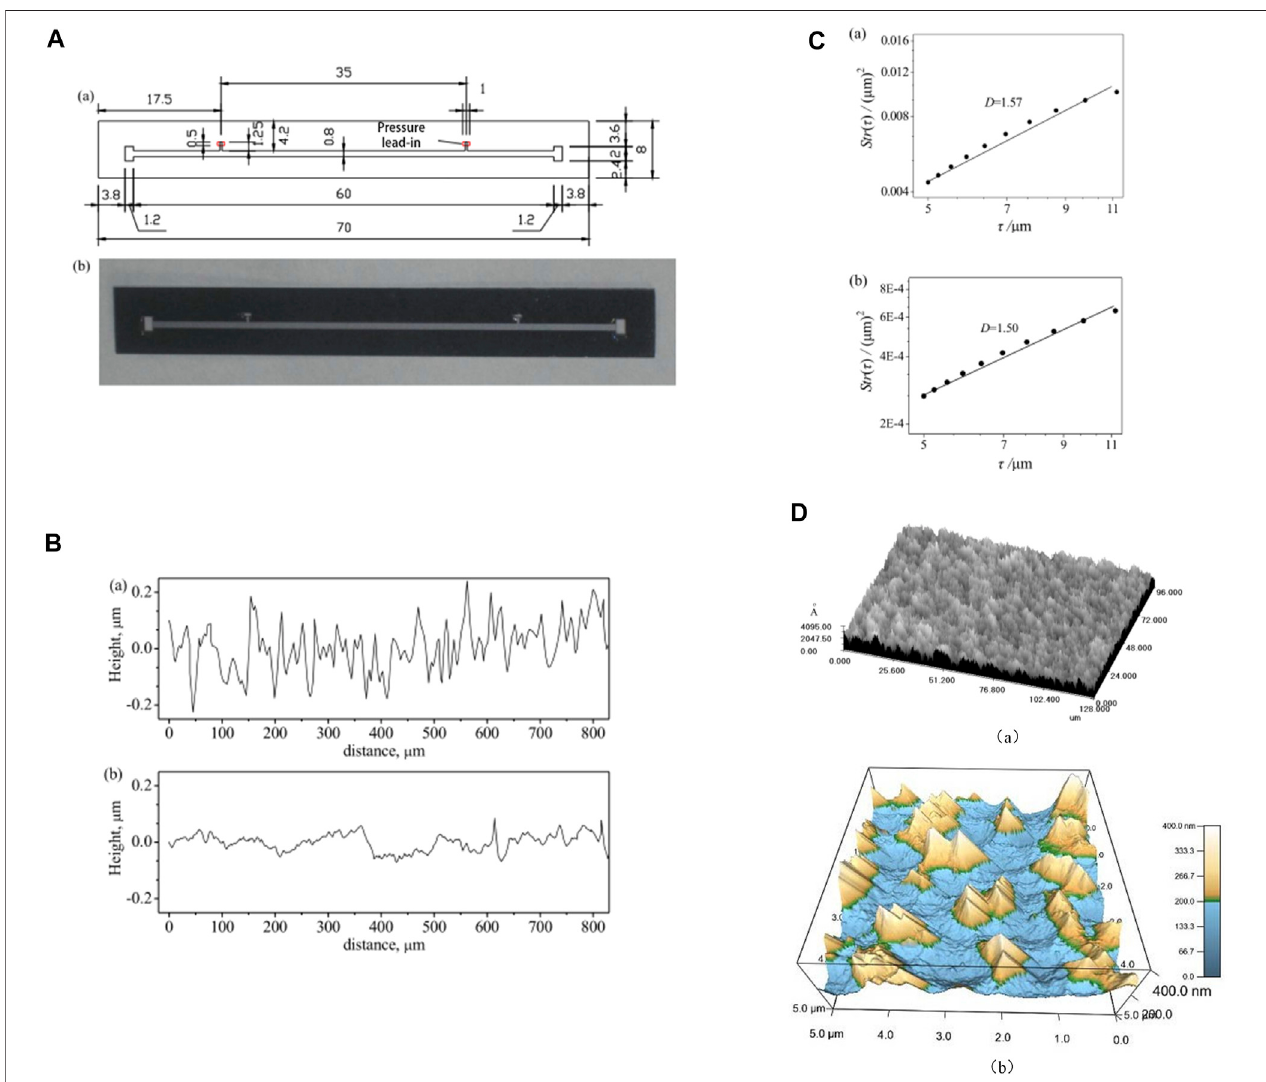
FIGURE1| Siliconmicrochannel (A) : (a) structuraldimensions(mm)and (b) realobject. (B) Surfaceroughnessdistribution: (a) siliconsurfaceand (b) glasssurface. (C) Structure function Str( τ ): (a) silicon surface, (b) glass surface. (D) Surface morphology: (a) confocal laser scanning microscope and (b) atomic force microscopy.